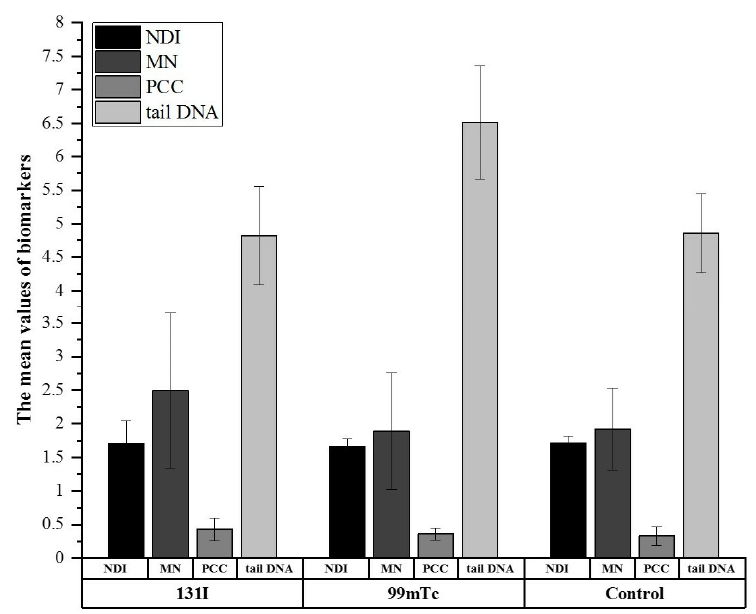
Figure 1. Mean values of biomarkers (NDI, MN, PCC, tail DNA) for human peripheral blood lymphocytes (HPBLs) of the 131 I, 99m Tc, and control groups. The error bars represent the standard deviation. Tail DNA is DNA damage detected by a single-cell gel electrophoresis assay.